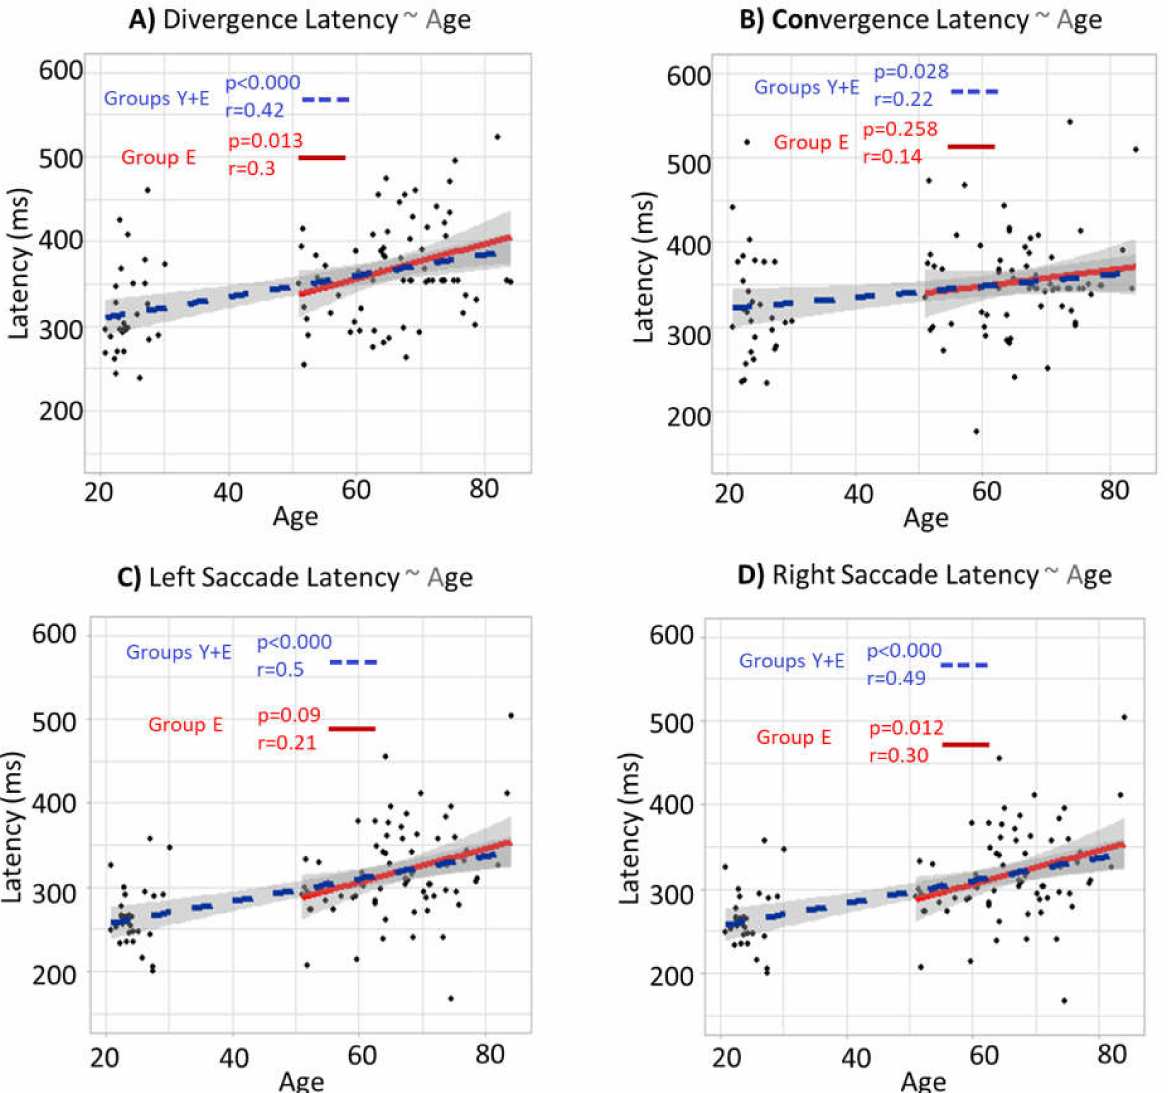
Figure 7. Correlations between eye movement latency and age for the whole population (Group Y + Group E) and Group E only. ( A ) Correlation and regression line between the divergence latency and age. ( B ) Correlation and regression line between the convergence latency and age. ( C ) Correlation and regression line between the left saccade latency (SNR50) and age. ( D ) Correlation and regression line between the right saccade latency and age. The blue dashed lines represent the regression lines for the whole population (Group Y + Group E). The red lines represent the regression lines for Group E only. The grey areas represent the 95% confidence level interval. The “ r ” represents the Pearson correlation coefficients, and the “ p ” represents the significances of the slopes of the regression